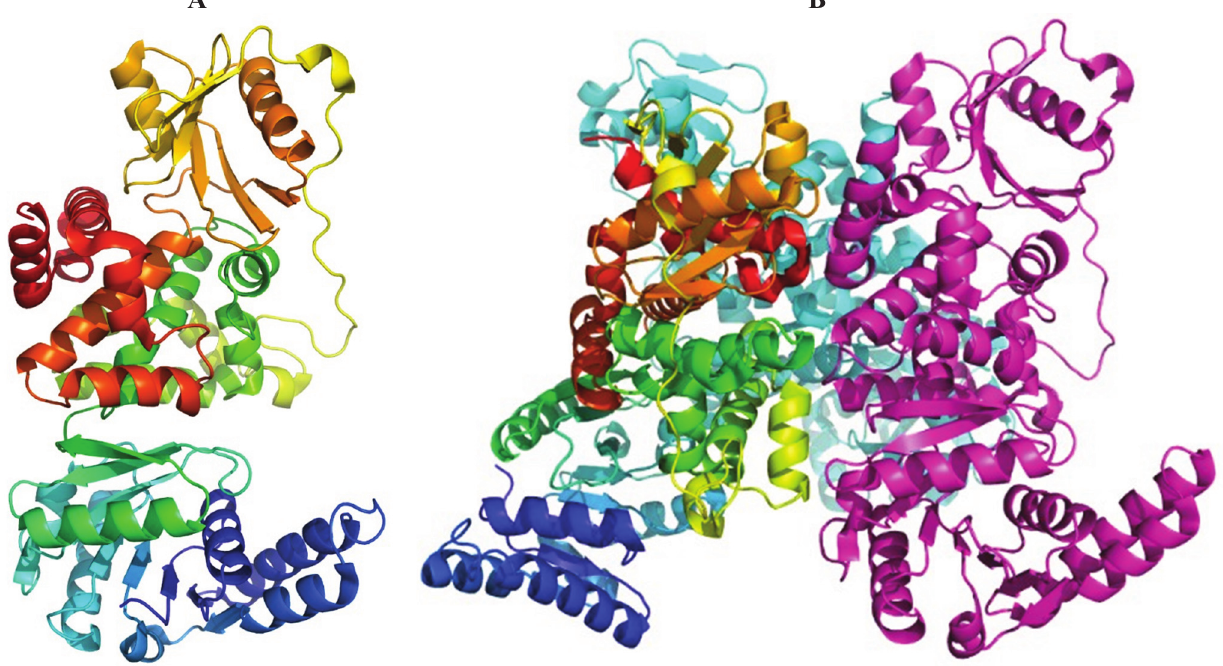
Figure 5. The structure of E. coli PaaH. ( A ) The cartoon representation of the monomer painted rainbow colors. The dimerization domain is made of two segments, the one following the N-terminal domain (in green) and the C-terminus (in red); ( B ) the structure of a trimer. The inter-monomer contacts involve mainly the oligomerization